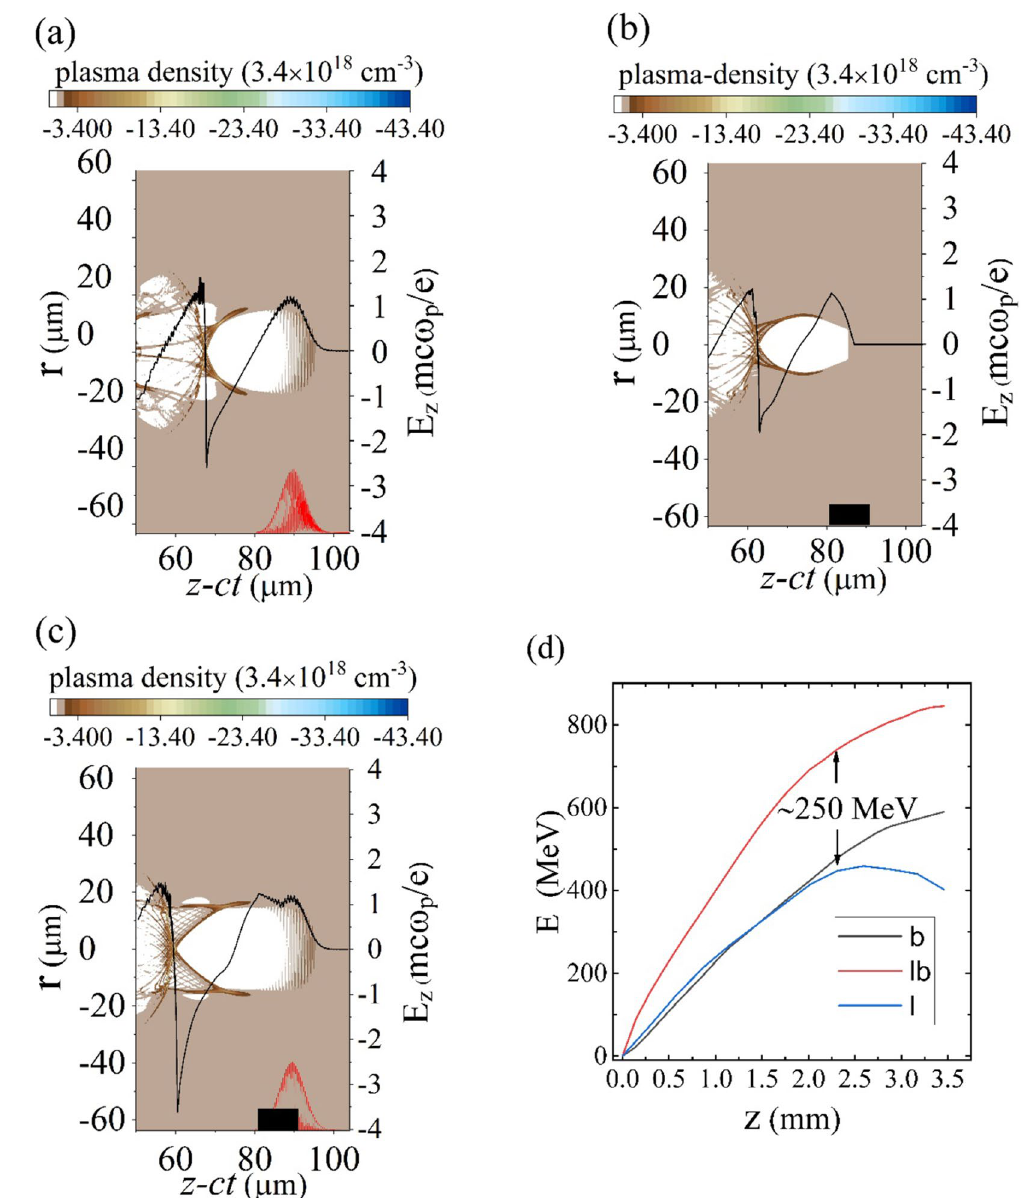
Figure 2. Background density snapshots and corresponding wakefield after 0.1 mm propagation distance for ( a ) LWFAs, ( b ) PWFAs and ( c ) hybrid laser and electron beam accelerators. Red and black lines show laser pulse and electron beam drivers location respectively. ( d ) Energy gain from the wake of the laser driver (blue), electron driver (black), and hybrid driver (red) for 3.5 mm propagation